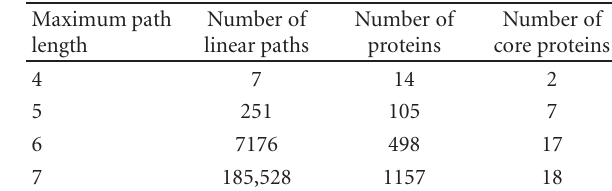
Table 2: Linear paths from INSR to GLUT4.